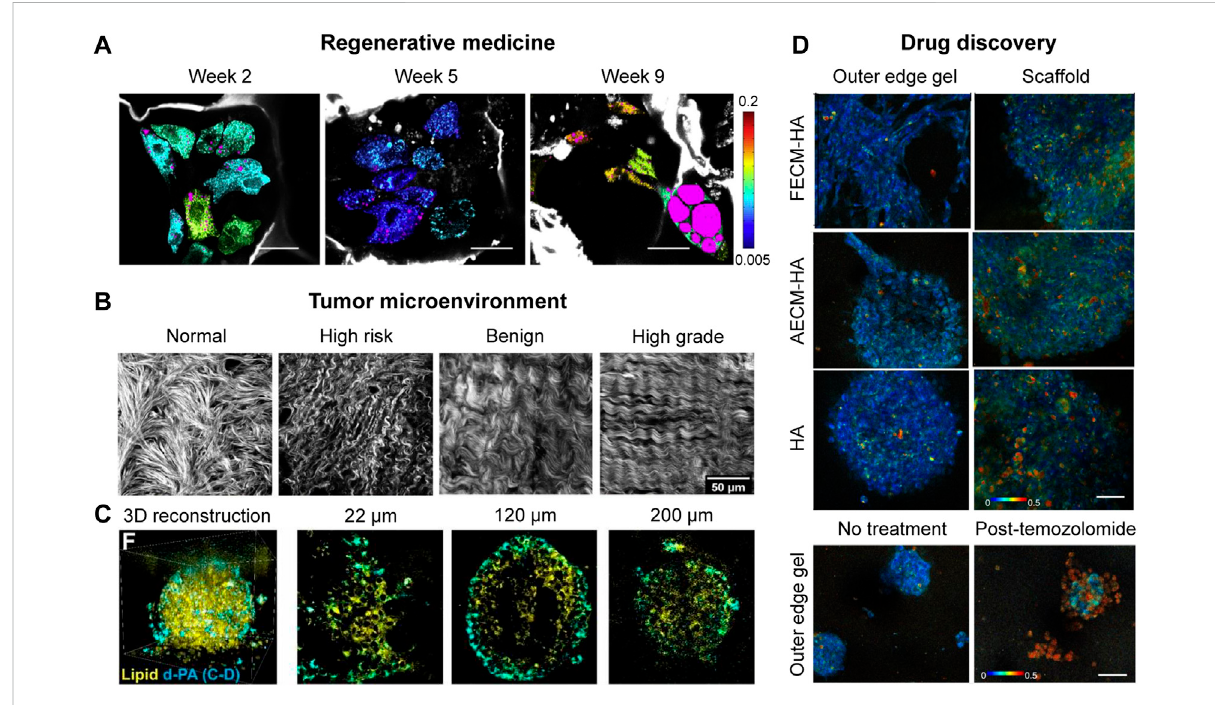
FIGURE 2 Applicationsoflabel-freeNLOimagingin3Dcellcultures. (A) FLIMcoupledwithTHGimagesofcellularredoxratiosandlipidcontent(magenta) in hMSCs embedded in 3D silk scaffolds, exposed to the adipogenic media for 2, 5 and 9 weeks, respectively. Redox scale color bar is shown on the right. Endogenous silk fl uorescence is shown in grayscale. Scale bars, 35 μ m (with permission) [44]. (B) SHG images of collagen fi bers from normal, high risk, benign, and high grade of ovarian tissues within fabricated scaffolds (with permission) [51]. (C) Volumetric SRS images and representative2Dimages(atz=22 μ m,120 μ m,and200 μ m)of3Dtumorspheroids.Lipiddropletschannelisshowningreen,andd 31 -palmiticacid channelisshown incyan.Scalebars, 50 μ m (withpermission) [55]. (D) Representative redox ratioimages ofglioblastoma cells withinhyaluronicacid (HA), HA supplemented with porcine brain-derived fatal ECM (FECM-HA), and HA supplemented with porcine brain-derived adult ECM